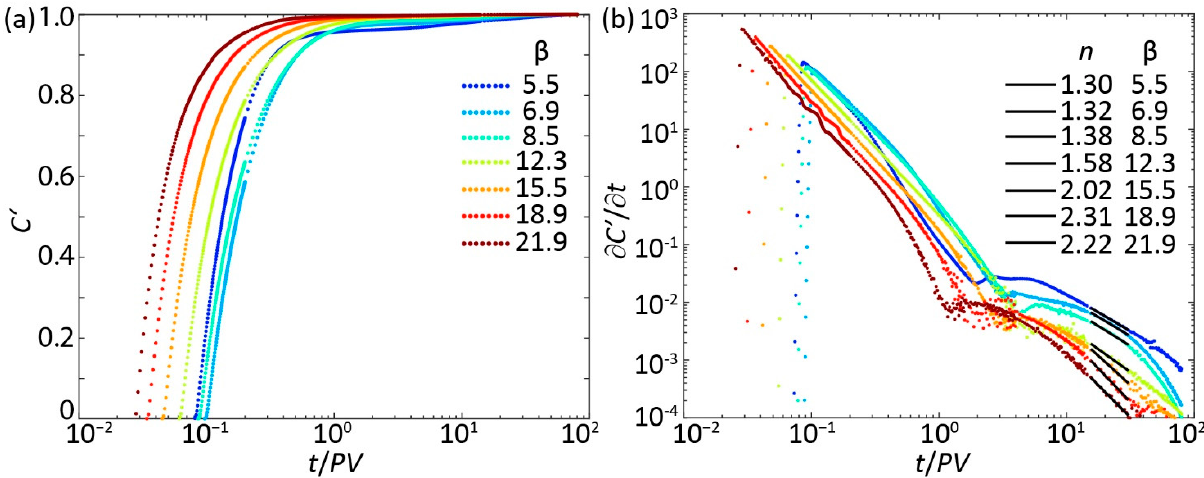
Figure 4. ( a ) The breakthrough curves, and ( b ) residence time distributions demonstrating early arrival and late time transport tailing, where different colored dots represent diverse pore geometries characterized by the dimensional hydraulic shape factor β . The black lines in ( b ) are power law functions with exponent ( n ) fitted to the late time portion of residence time distributions, C ′ is dimensionless concentration, t is time, and PV is pore volume.